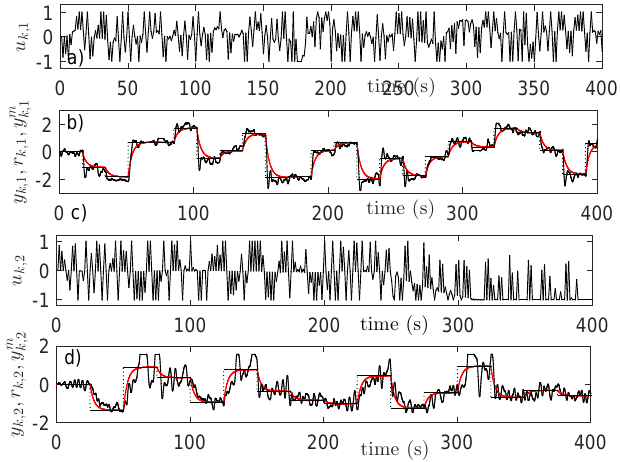
Figure 5. IO data collection with the linear controller: ( a ) u k ,1 ; ( b ) y k ,1 (black), y m (black dotted); ( c ) u k ,2 ; ( d ) y k ,2 (black), y m